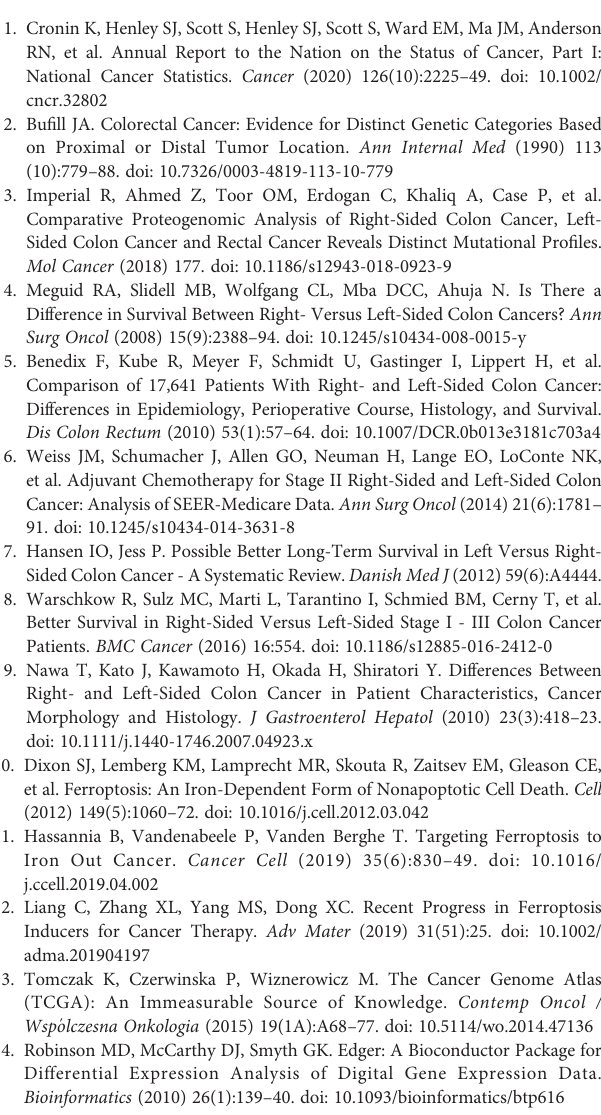
Supplementary Table 2 | ThechoicecriterionfortheDEGs(high-riskgroupinLCRC/ RCRC vs. low-risk group in LCRC/RCRC). P < 0.05 and |log2 fold change (FC)| >